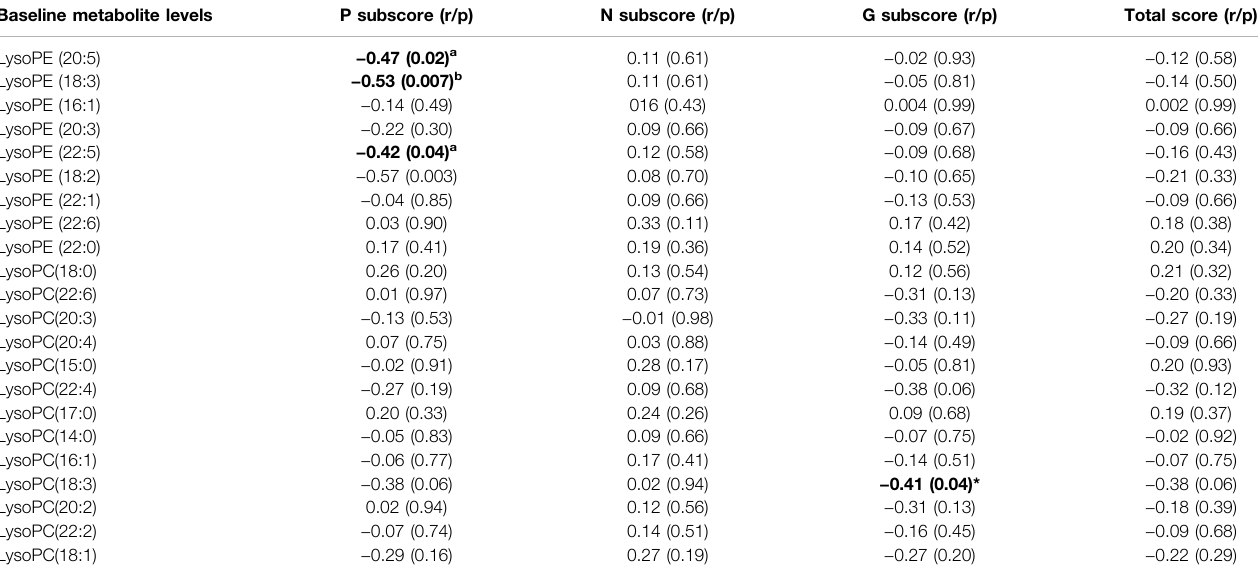
TABLE 4 | The correlation between the baseline metabolite levels and the reduction of clinical symptoms. Baseline metabolite levels